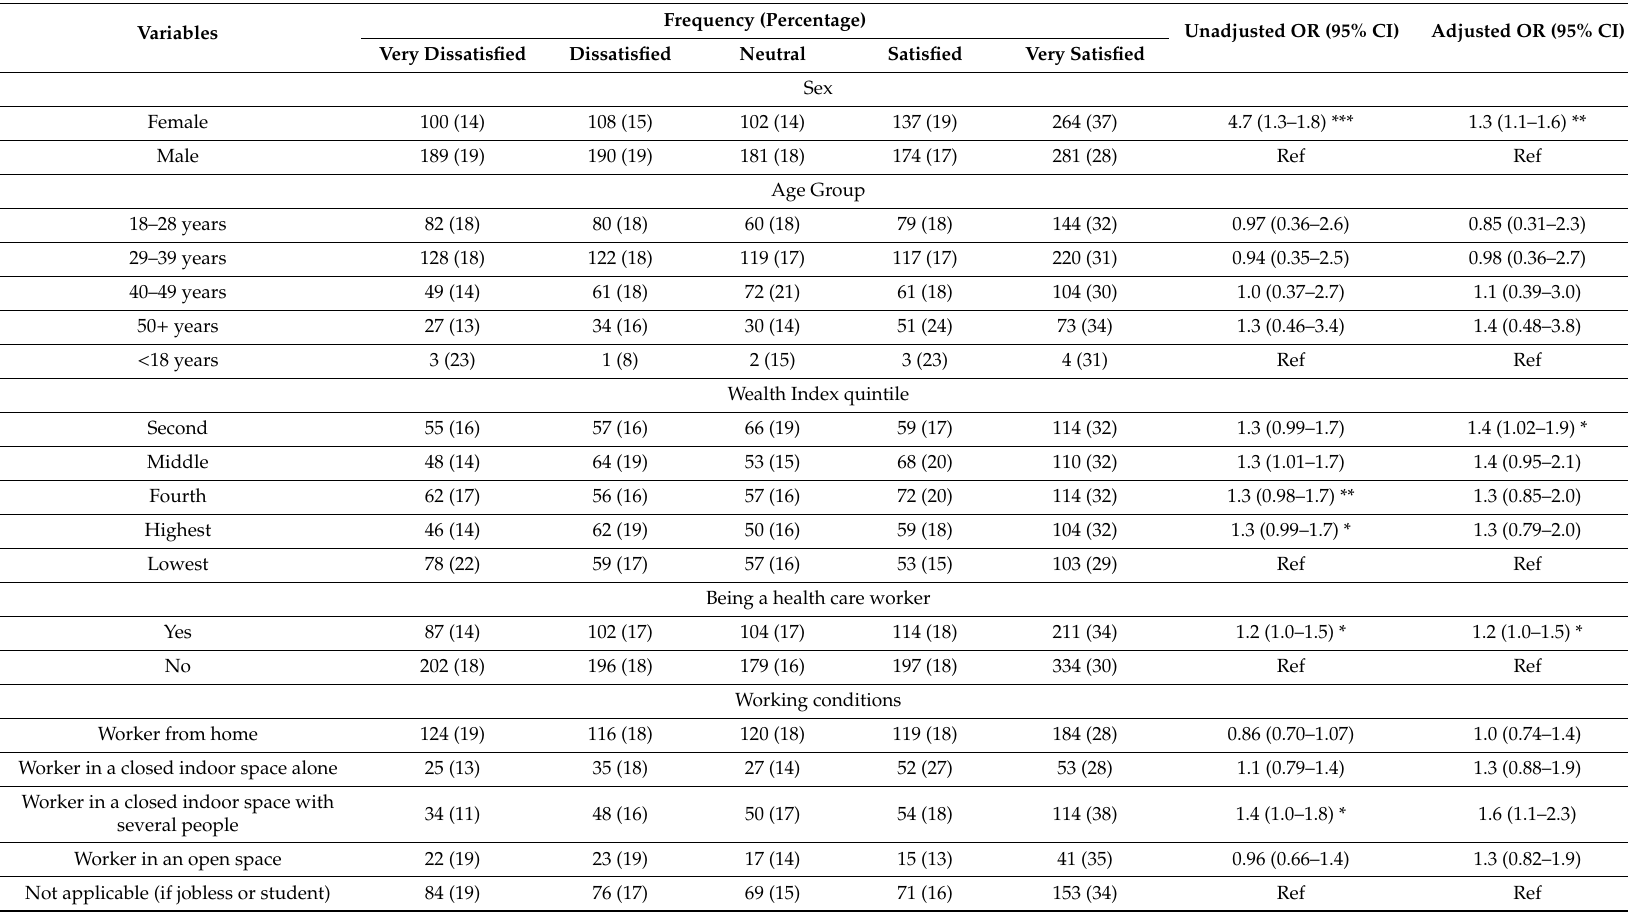
Table 5. Determinants of level of satisfaction with COVID-19 preventive measures in the first stage of the outbreak, Uganda.